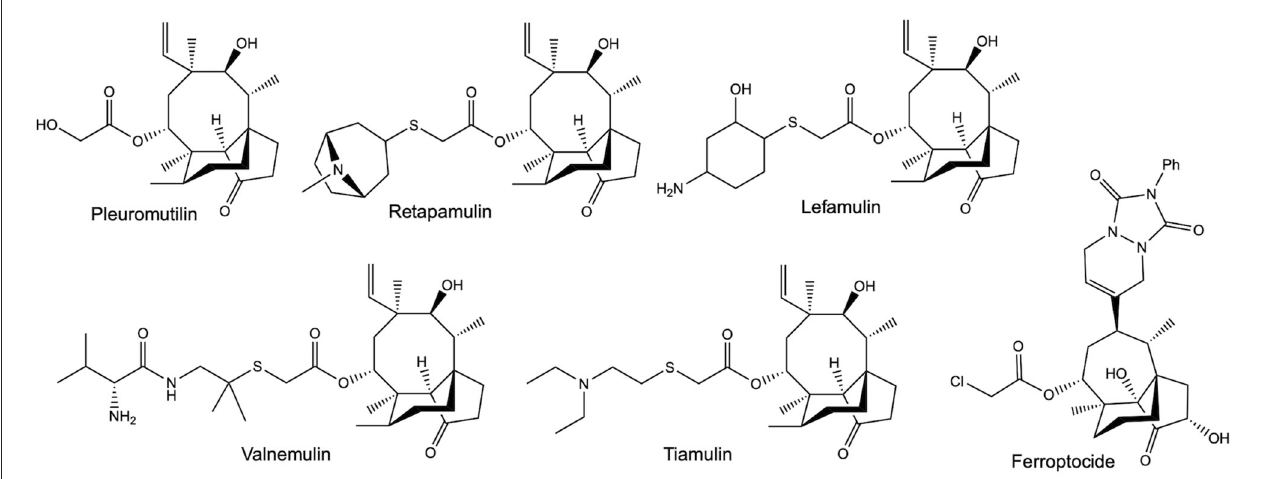
FIGURE 1 | The structures of pleuromutilin and various pleuromutilin derivatives. Valnemulin and tiamulin are used in veterinary medicine as antibiotic agents. Retapamulin and Lefamulin both have approval for use in human medicine, as topical and oral / intravenous antibiotics, respectively. Ferroptocide is a recently produced antitumour derivative, which triggers ferroptosis via the inhibition of